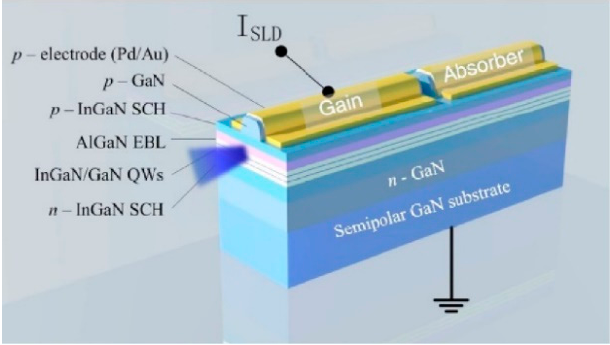
Figure 6. Schematic of a SLD [77] . © 2016 Optical Society of America.